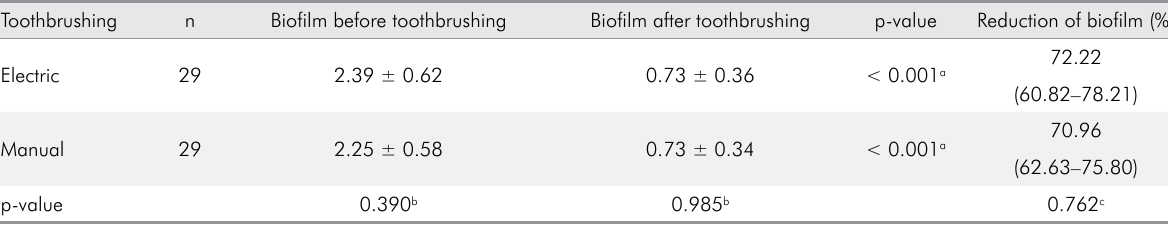
Table 2. Analysis of total biofilm (mean ± SD) before and after toothbrushing and the percent reduction of biofilm (median (25 th -